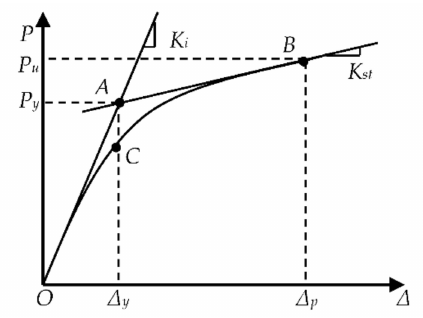
Figure 8. Definition of characteristic